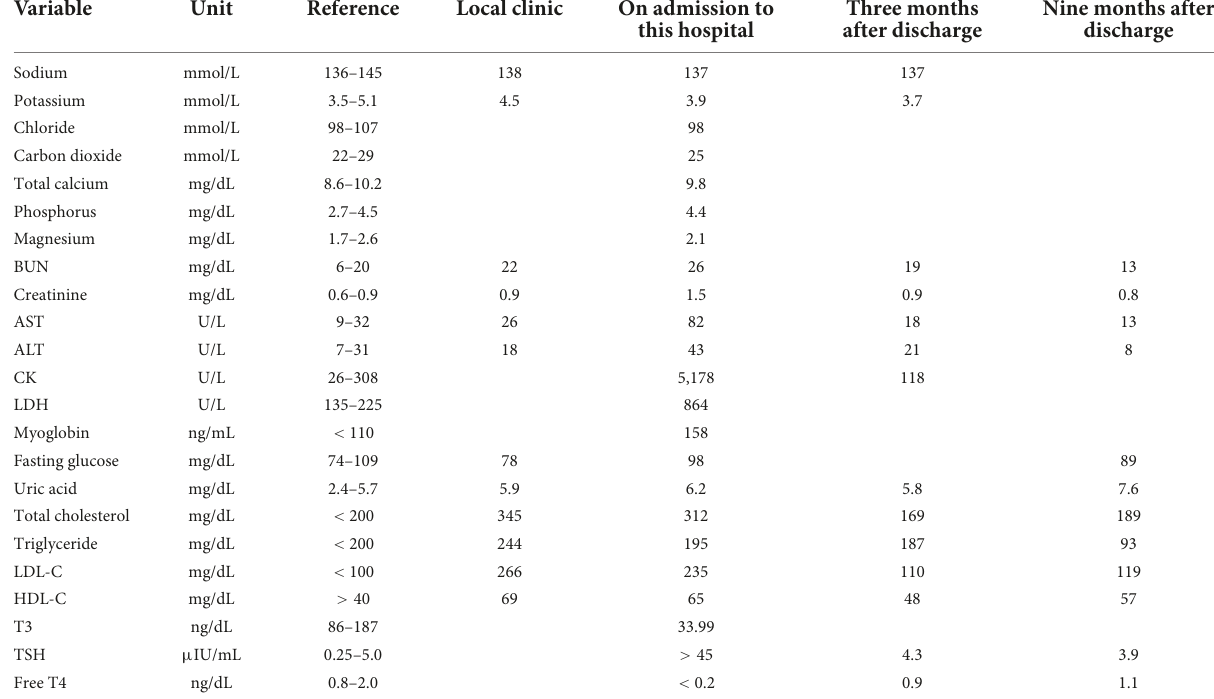
TABLE 1 Laboratory data.